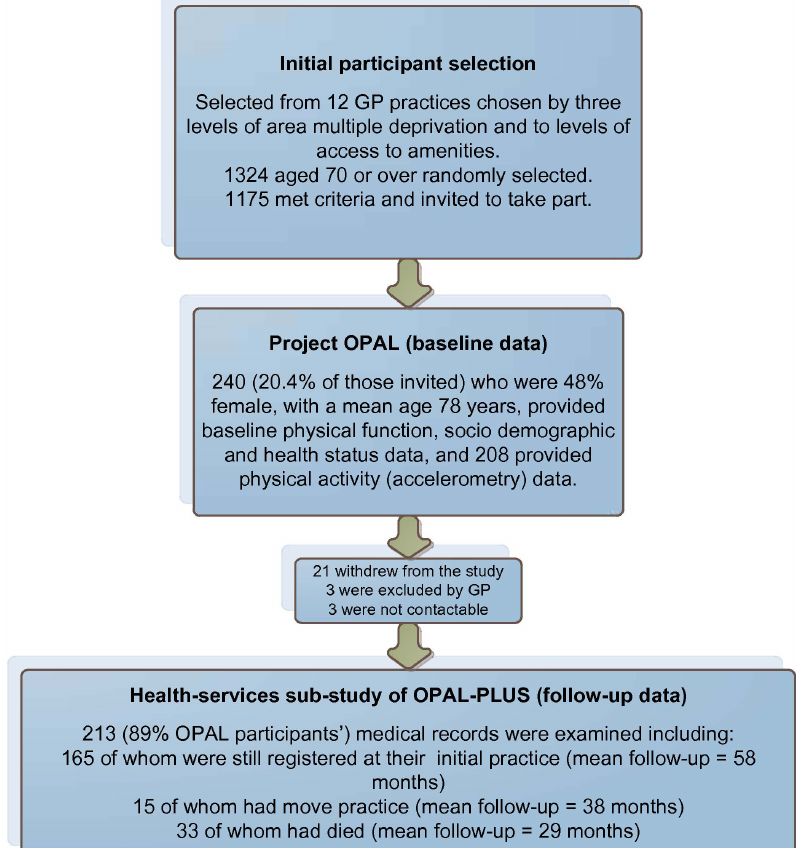
Figure 1. Participant selection and involvement.